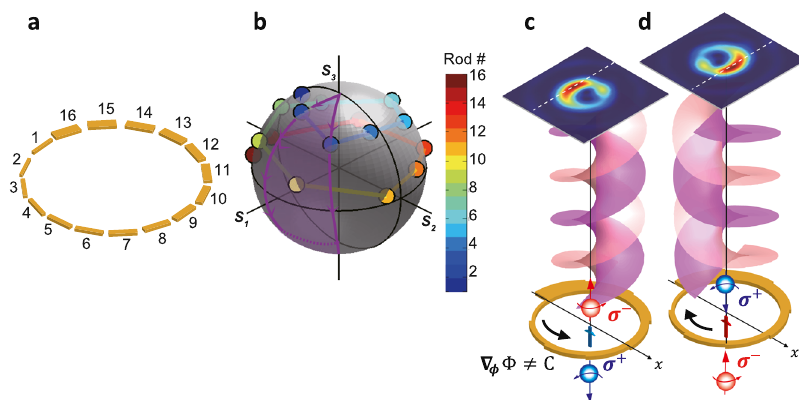
Figure 2: Circular array of nano-rods with a non-constant azimuthal gradient total phase and Poincaré sphere plot of Stokes parameters. (a) Circular array of